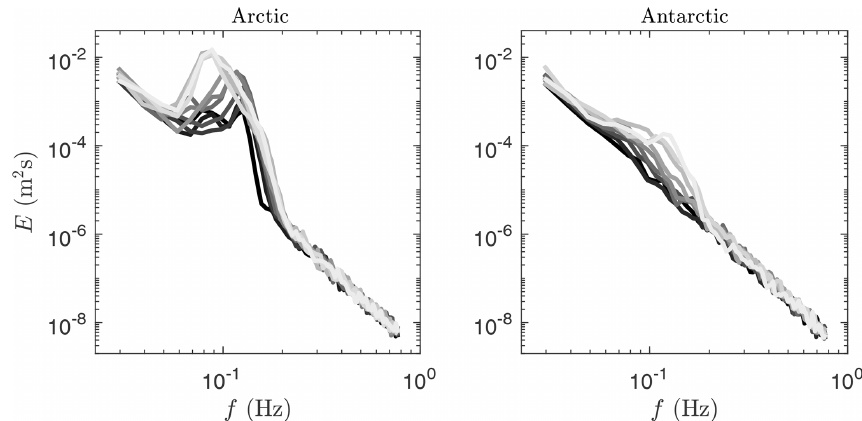
Figure A2. Example spectra derived from the vertical acceleration measured by the ice buoys. For the Arctic, the spectra are from 22 March 2020 (black)–23 March 2020 (light gray). For the Antarctic, the spectra are from 31 October 2020 (black)–2 November 2020 (light gray). For the Antarctic, only a few spectra pass the SNR